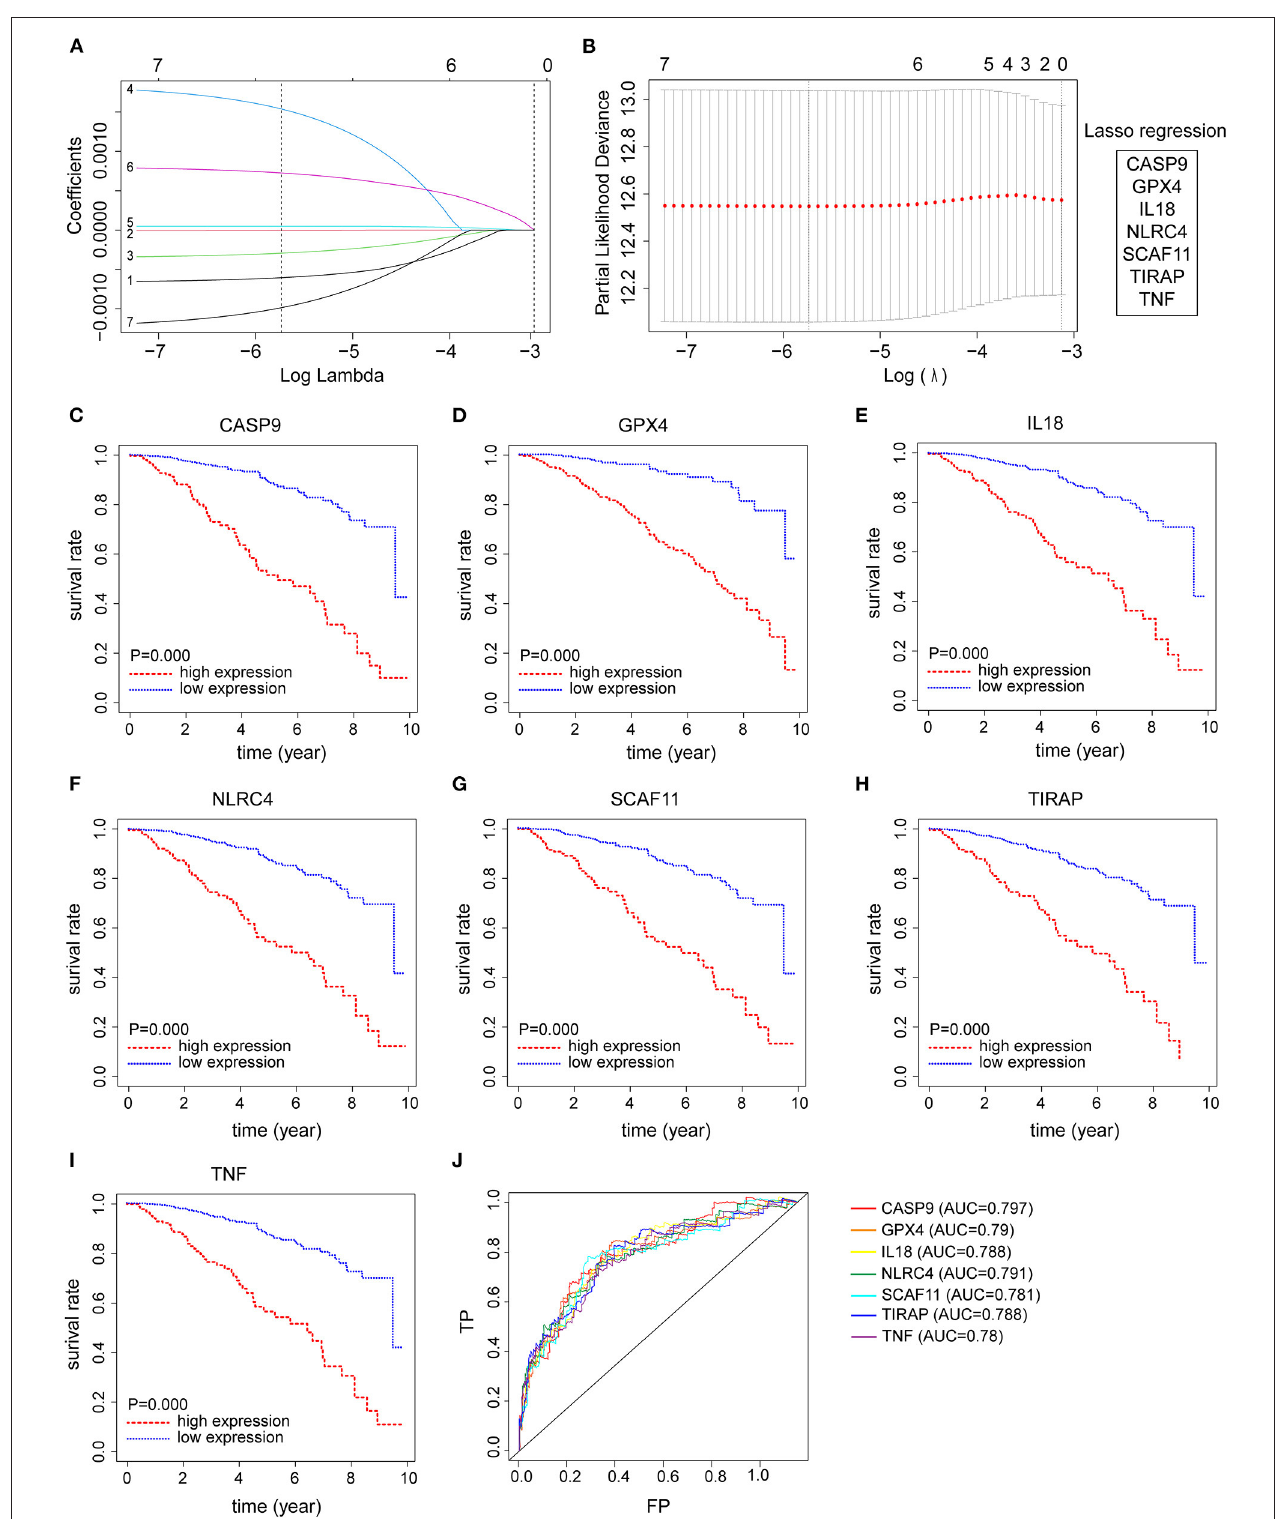
FIGURE 2 | Identification of seven pyroptosis-related genes with prognostic power in breast cancer (BRCA) patients. (A,B) Seven pyroptosis-related genes with prognostic value were identified by LASSO Cox regression, including CASP9, GPX4, IL18, NLRC4, SCAF11, TIRAP, and TNF. (C–I) Kaplan-Meier survival analysis was employed to evaluate the prognostic capability of these candidate genes, respectively. (J) Time-dependent ROC curves were applied to assess the prognostic value of seven pyroptosis-related gene signature in the TCGA-BRCA cohort.